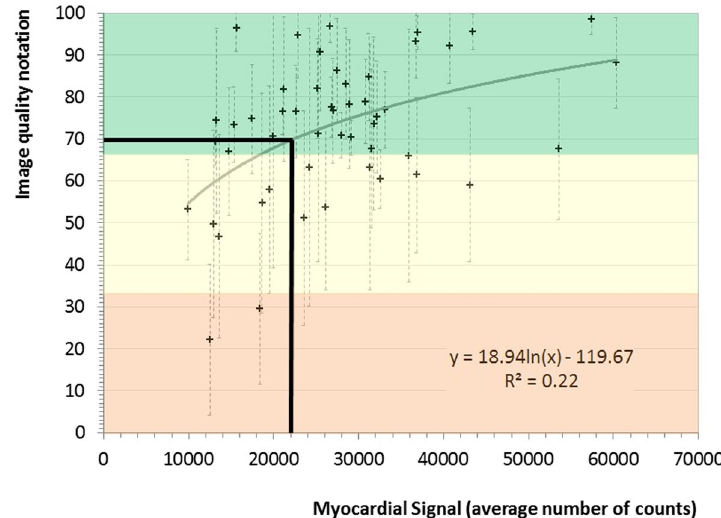
Fig. 4 Image quality of the uncorrected stress‑test SPECT images of the 50‑patient subcohort. The image quality at different myocardial signals was scored by seven nuclear physicians. Black crosses and gray error bars, respectively, indicate the average and standard deviation of the image quality scores recorded by the physicians. The orange, yellow, and green areas indicate poor (score < 33), intermediate (score 33–66), and good (score > 66) image quality, respectively. The gray curving line represents the logarithmic regression of the data. The black landmarks show how the chosen MS threshold of 22,000 counts corresponds to the expected image quality. An image quality score of around > 70 signifies good image quality